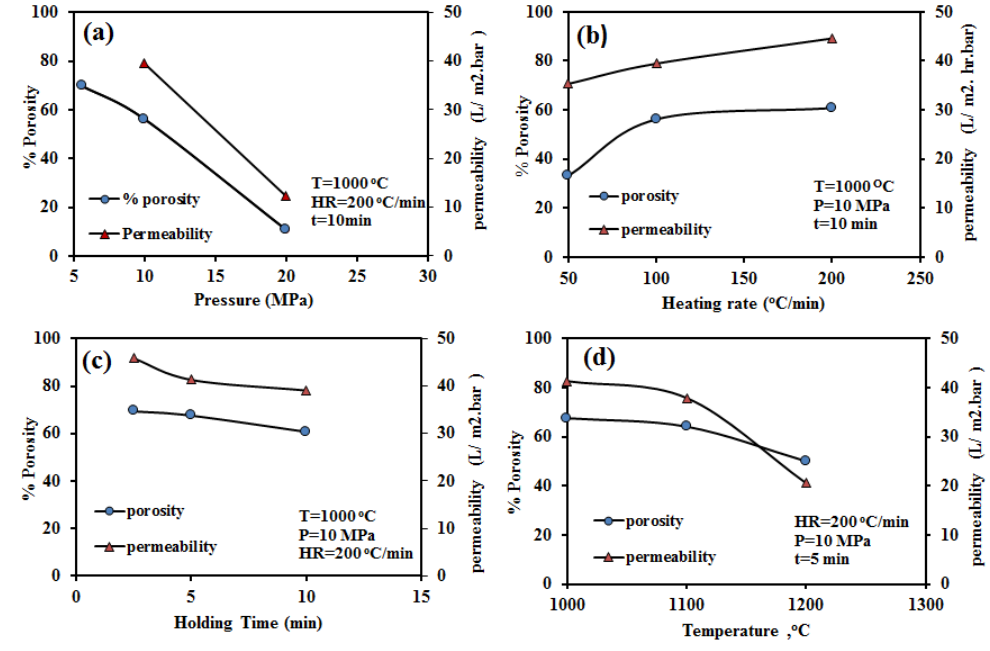
Figure 6. Variation in membrane porosity and permeability with SPS process parameters: ( a ) pressure, ( b ) heating rate, ( c ) holding time, and ( d ) temperature.